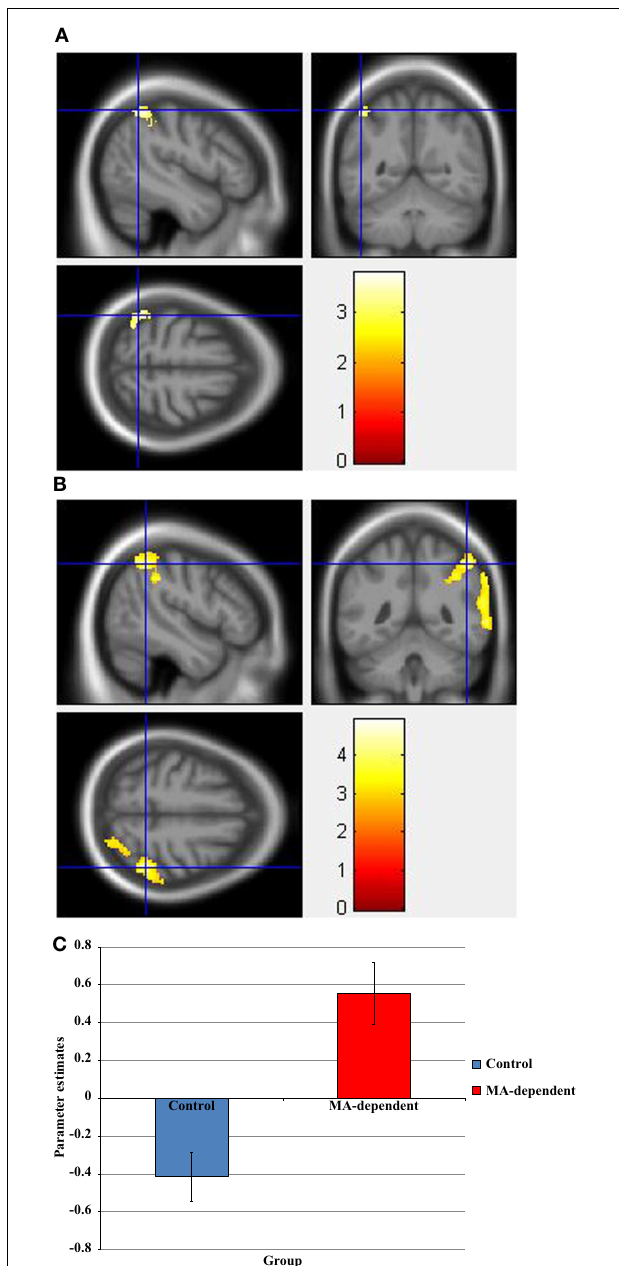
FIGURE 2 |Whole-brain two-sample t -test results for the Stroop effect condition showing pre-drug MA-dependent > control group differences in activation of: (A) the left inferior parietal lobule [peak voxel MNI co-ordinates (mm): ( − 46, − 54, 58); T 31 = 3.81, p < 0.05 cluster-corrected], (B) the right inferior parietal lobule [peak voxel MNI co-ordinates (mm): (48, − 48, 52); T 31 = 4.62, p < 0.05 cluster-corrected], and (C) Plot of the mean ± standard error parameter estimates representing the percentage blood-oxygen-level-dependent signal change within the right inferior parietal lobule .The scale represents the color (from red to yellow) of the cluster corresponding to the increasing t -statistic.The structural image represents the IXI550 average normal brain which has been registered to the MNI152 space with corresponding inferior–superior co-ordinates.